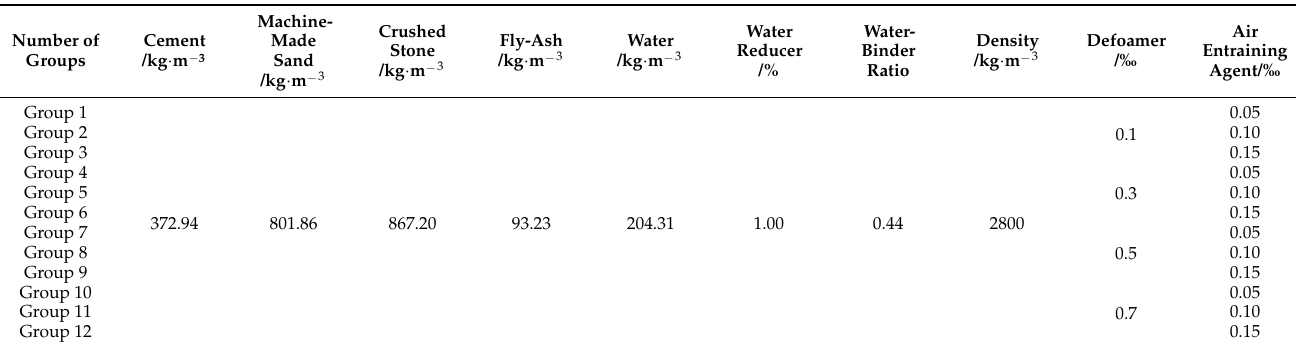
Table 3. Basic material mix ratio of C30 SCFFC.